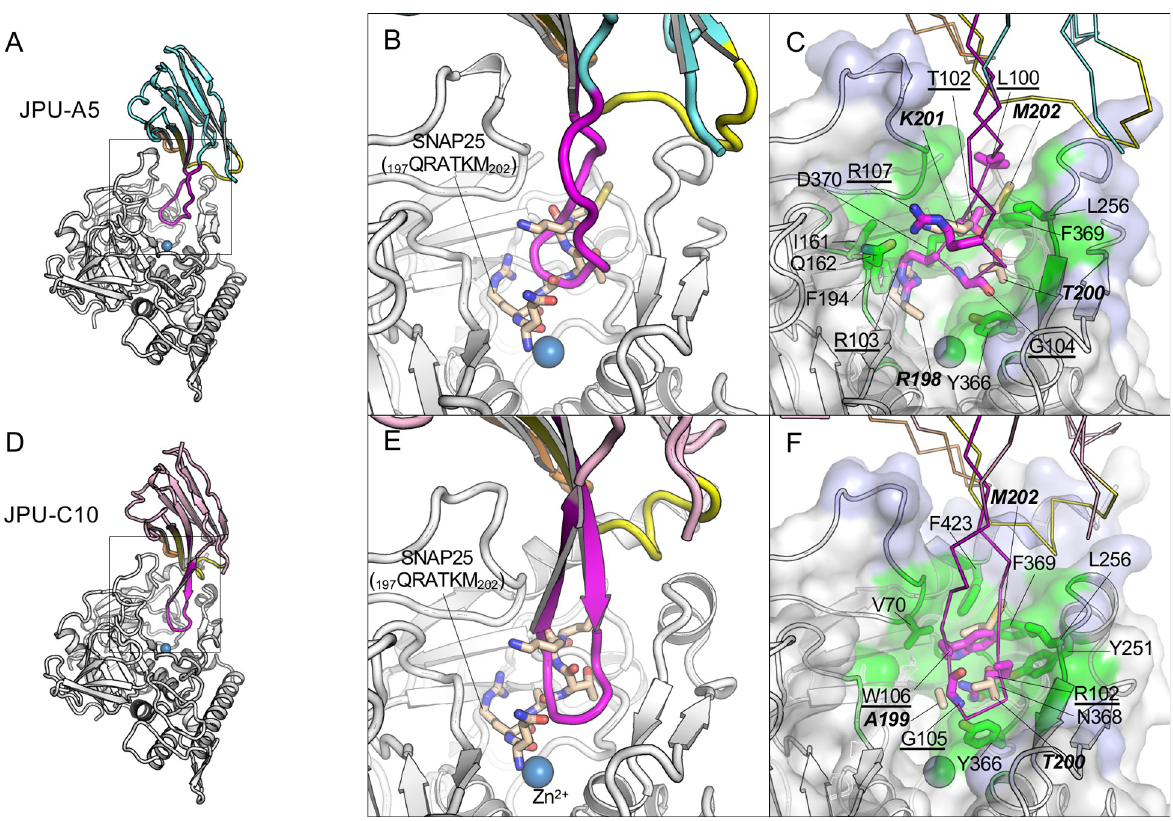
Fig 2. JPU-A5 and JPU-C10 inhibit the binding of SNAP25 to the β -exosite of LC/A. (A, D) Cartoon representation of JPU-A5 (A) and JPU-C10 (D) in complex with LC/A. The CDR1, 2, and 3 are colored yellow, orange, and magenta, respectively. The framework region (FR) of JPU-A5 and JPU-C10 are colored cyan, pink, and light green, respectively. (B, E) Superposition of LC/A–JPU-A5 (B) or LC/A–JPU-C10 (E) with the SNAP25(197–202)-bound LC/A (PDB ID: 3DDA). Only the VHH-bound LC/A colored white is represented in (B) and (E) for clarity, while SNAP-25 peptide is colored wheat. (C, F) JPU-A5 (C) and JPU-C10 (F) competes with SNAP25 residues for LC/A binding. Molecular surface of LC/A is presented to highlight the binding epitopes. The VHH-binding epitopes on LC/A are colored blue, while the regions overlapping with SNAP25 binding are colored green. Key VHH residues that interfere with SNAP25 binding and the corresponding interacting LC/A residues are drawn as sticks.